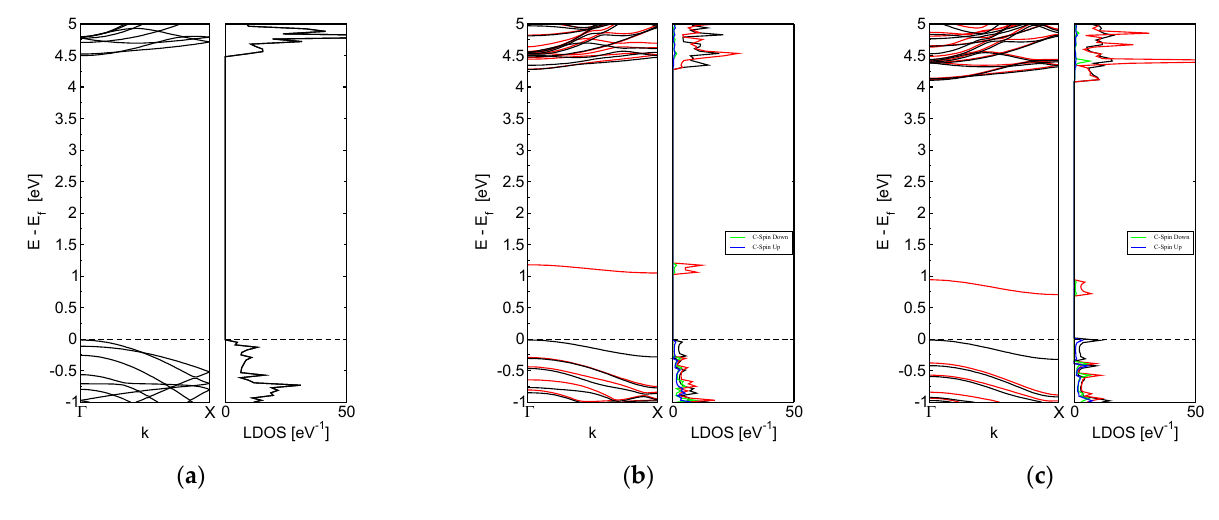
Figure 2. Electronic properties of the analyzed systems: ( a ) pristine BNNR, ( b ) E_M ‐ BNNR, and ( c ) C_M ‐ BNNR. Graphs represent the band structure with the corresponding total density of states.